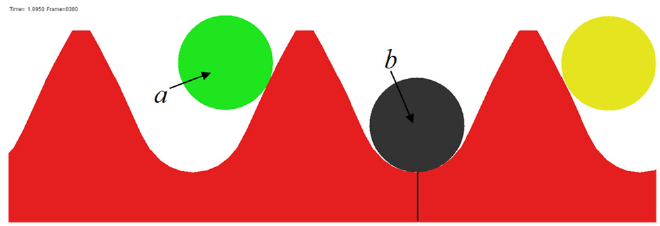
Figure 12. Simulation result of point 4. Figure 13 corresponds to the simulation result of point 5 in Figure 8. The number of simulation steps at this time is the 529nd. The moving distance of the rack is 52.900 mm at this moment, and the corresponding roller pinion angle is 50.5158°.